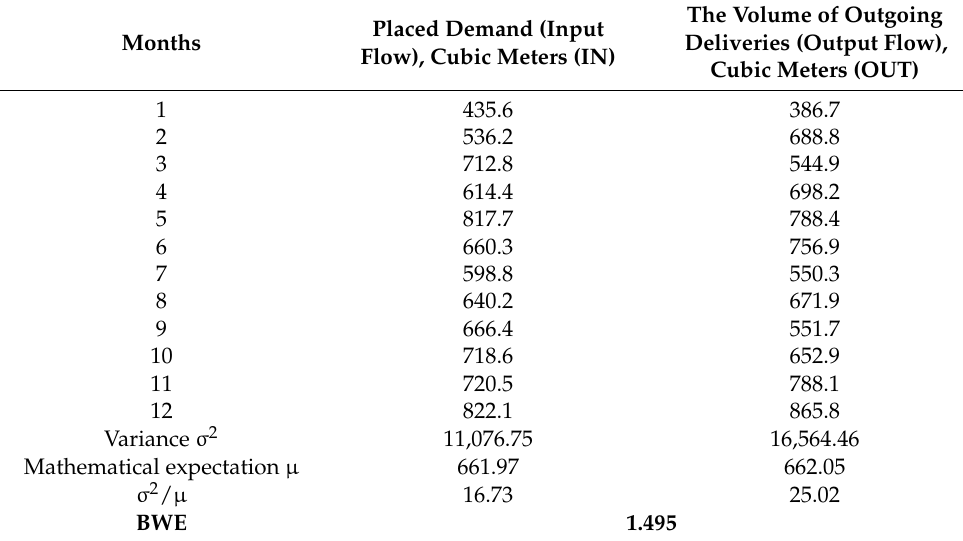
Table 3. Calculation of the BWE index (“as is”